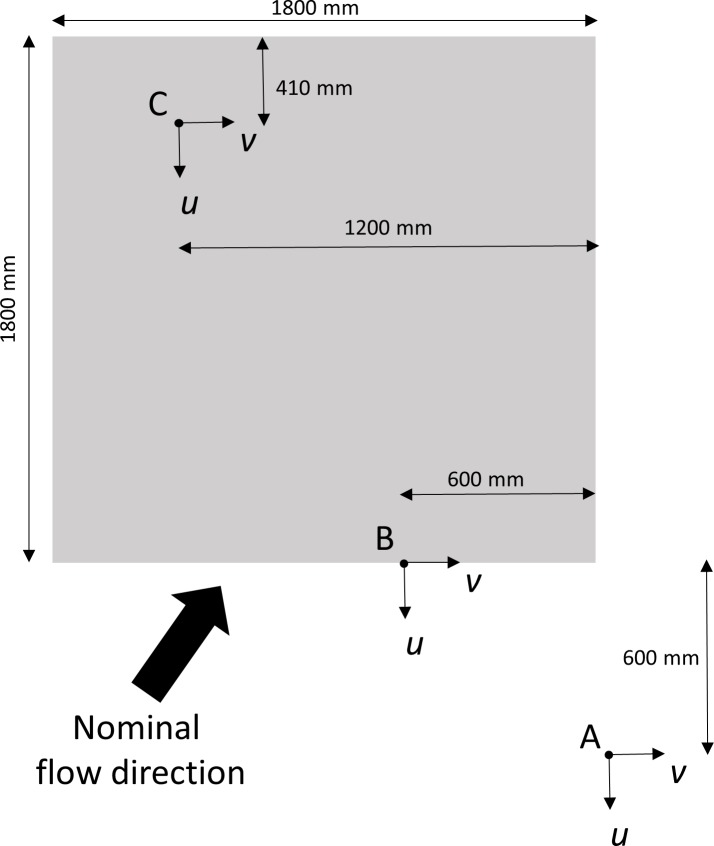
Schematic diagram of experimental setup for the ADV measurements showing the position of three measurement locations (A, B and C) relative to the ASU. Also shown is the orientation of the longitudinal (u) and transverse (v) velocity components relative to the orientation of the ASU. The vertical (w) velocity component was orientated in a positive direction away from the seabed.